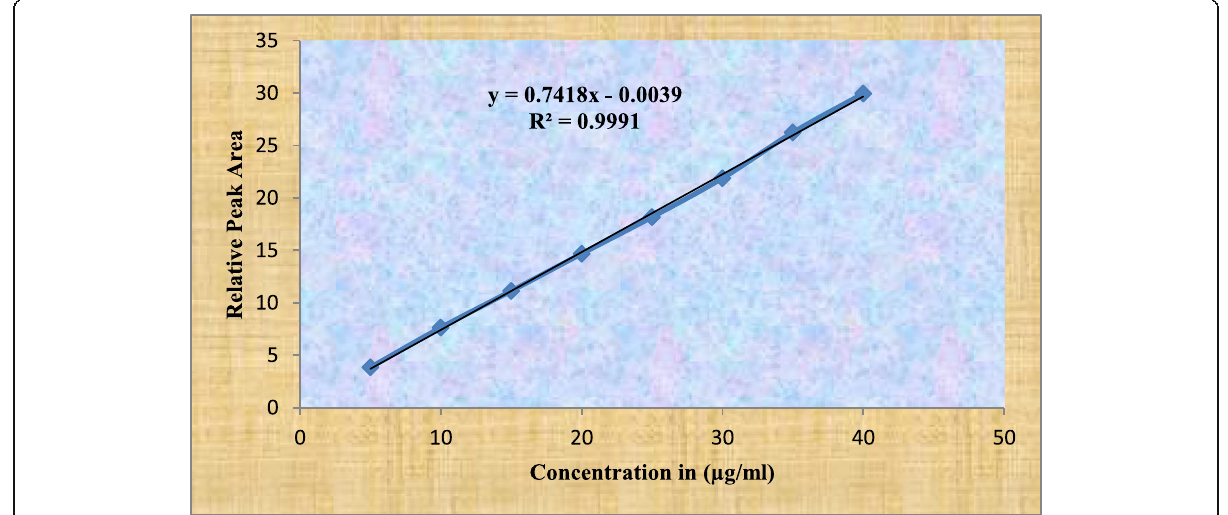
Fig. 5 Calibration curve of Simethicone for quantitative estimation